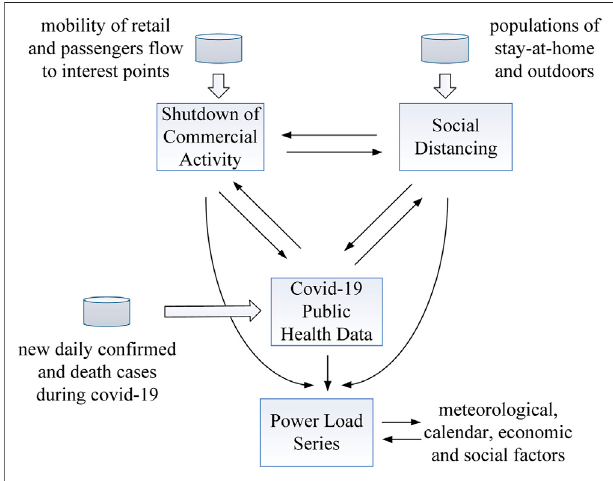
FIGURE 2 | Coupling relationship between COVID-19 related factors.